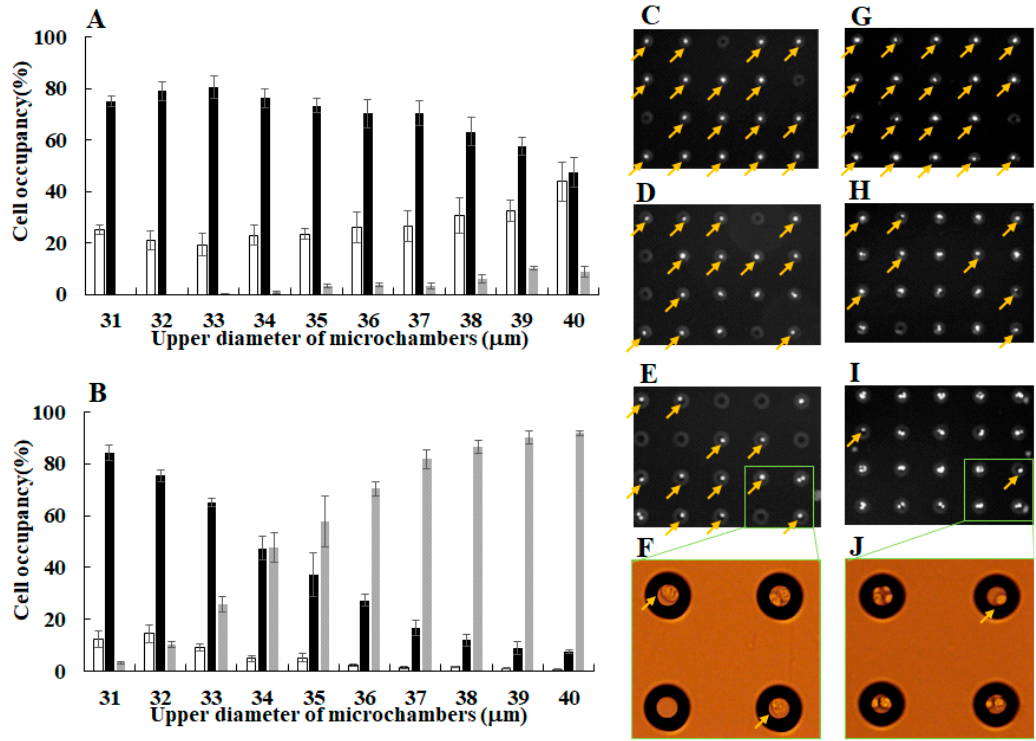
Figure 5. Optimization of single-cell separation using different sizes of microchambers. The graph indicates the percentage of single-cell occupancy for ( A ) NCI-H1650 and ( B ) CCRF-CEM cells in different microchamber diameters (31–40 µm upper diameter). Open bar: no cells. Closed bar: single cells only. Gray bar: two or more cells. Fluorescence images of single-cell occupancy for ( C – E ) NCI-H1650 and ( G – I ) CCRF-CEM stained with DAPI in different size of the microchambers. Fluorescence images of NCI-H1650 cell occupancy in ( C ) 32 µm, ( D ) 35 µm, and ( E ) 39 µm upper diameter of the microchambers. Fluorescence images of CCRF-CEM cell occupancy in ( G ) 31 µm, ( H ) 34 µm, and ( I ) 38 µm upper diameter of the microchambers. Magnified pictures show light microscopic images of ( F ) NCI-H1650 and ( J ) CCRF-CEM cell confined in the microchambers. Arrows indicate single-cell confinement in the microchambers.